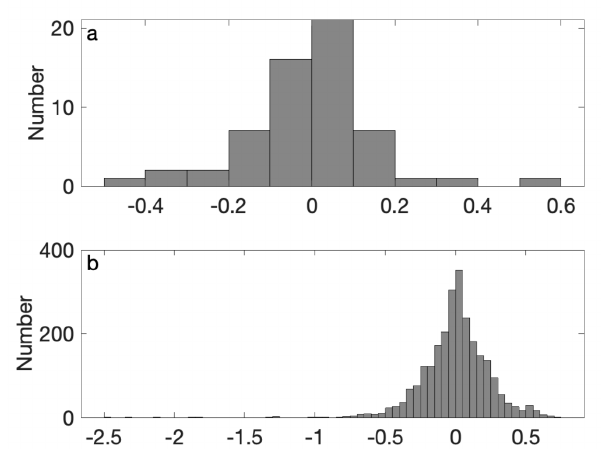
Figure 11. As in Figure 7, but for SPURS-2.